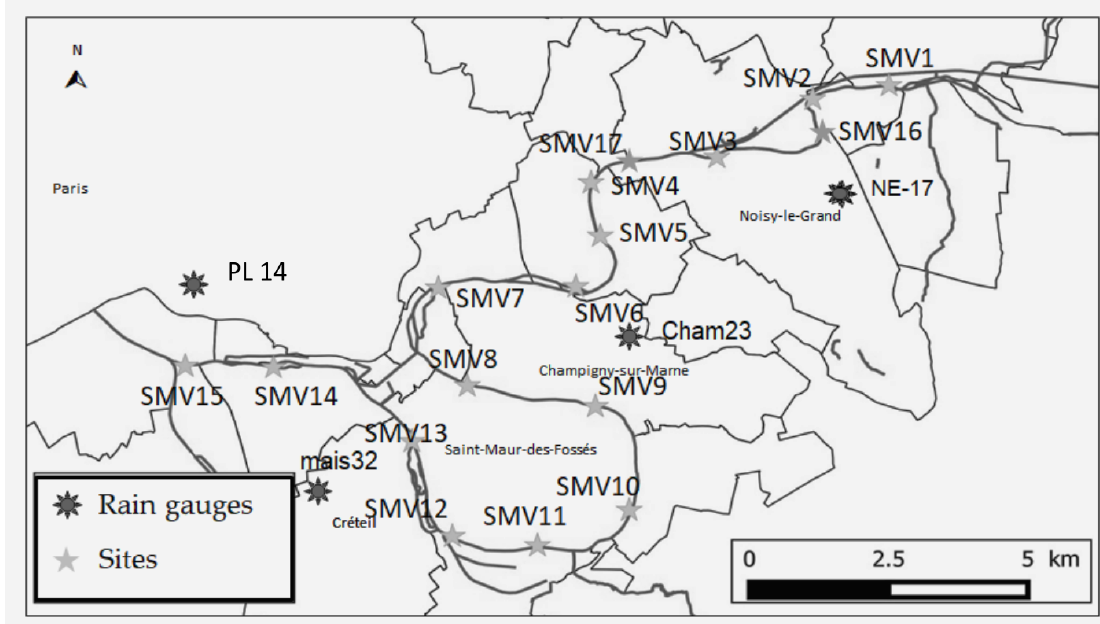
Figure 1. Marne River water quality monitoring stations. The light gray stars indicate the SMV sampling stations and the dark gray stars indicate the location of the rain gauges used